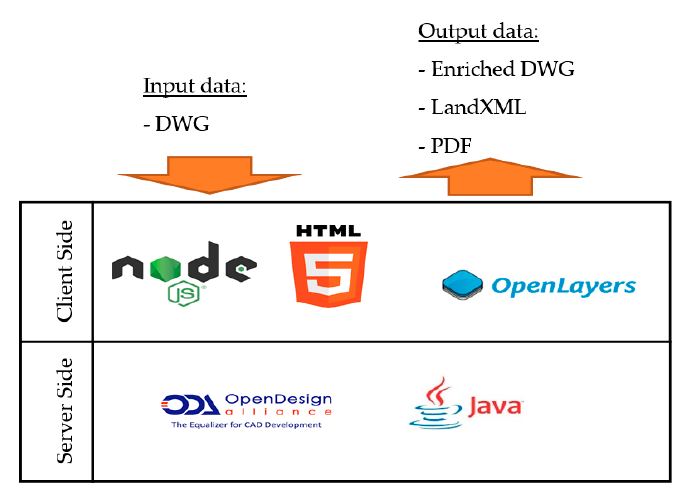
Figure 4. The overall system architecture for single smart cadastral platform PoC.